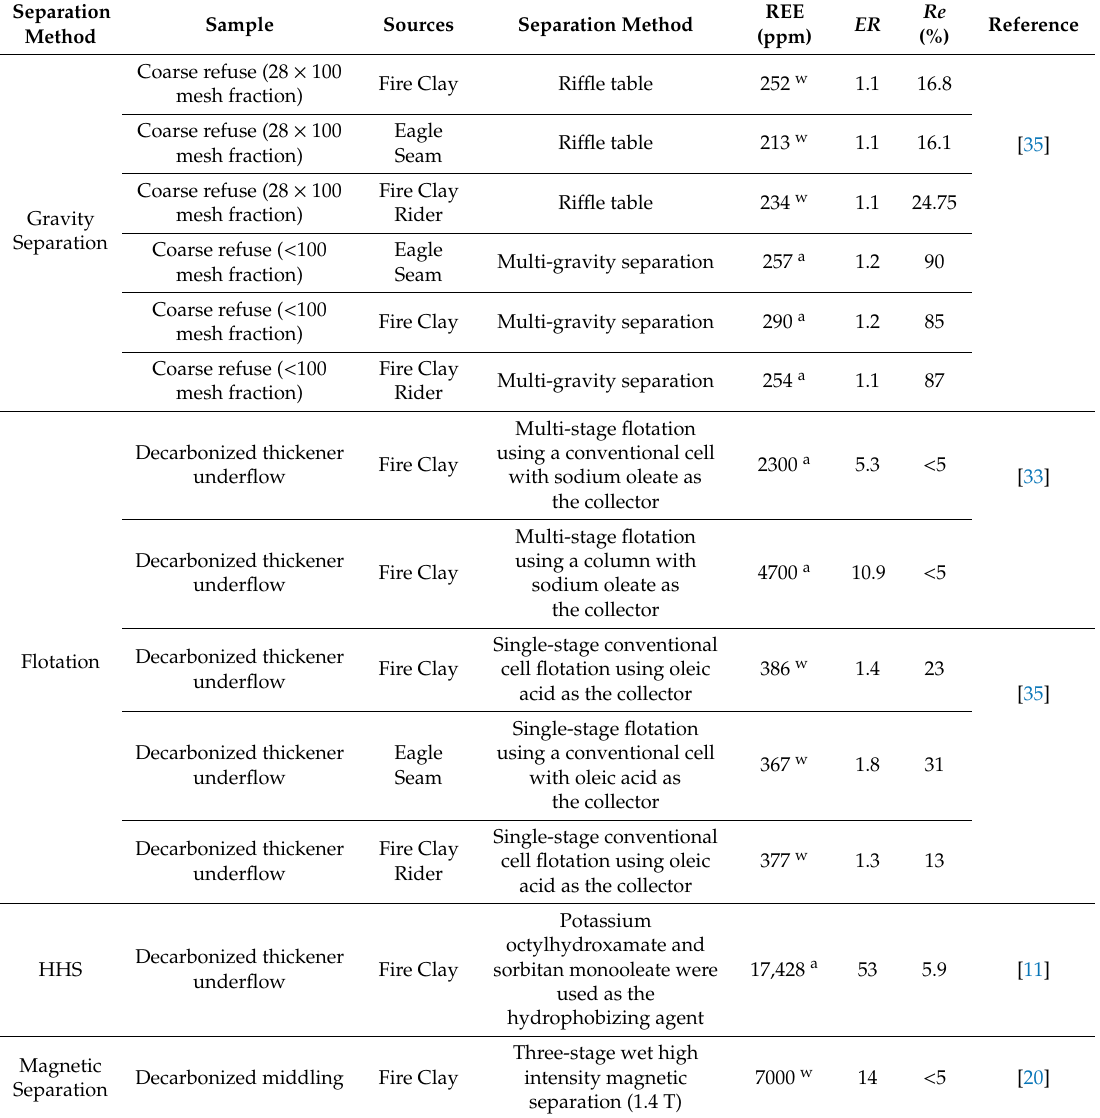
Table 1. A summary of physical beneficiation of rare earth minerals from coal and coal